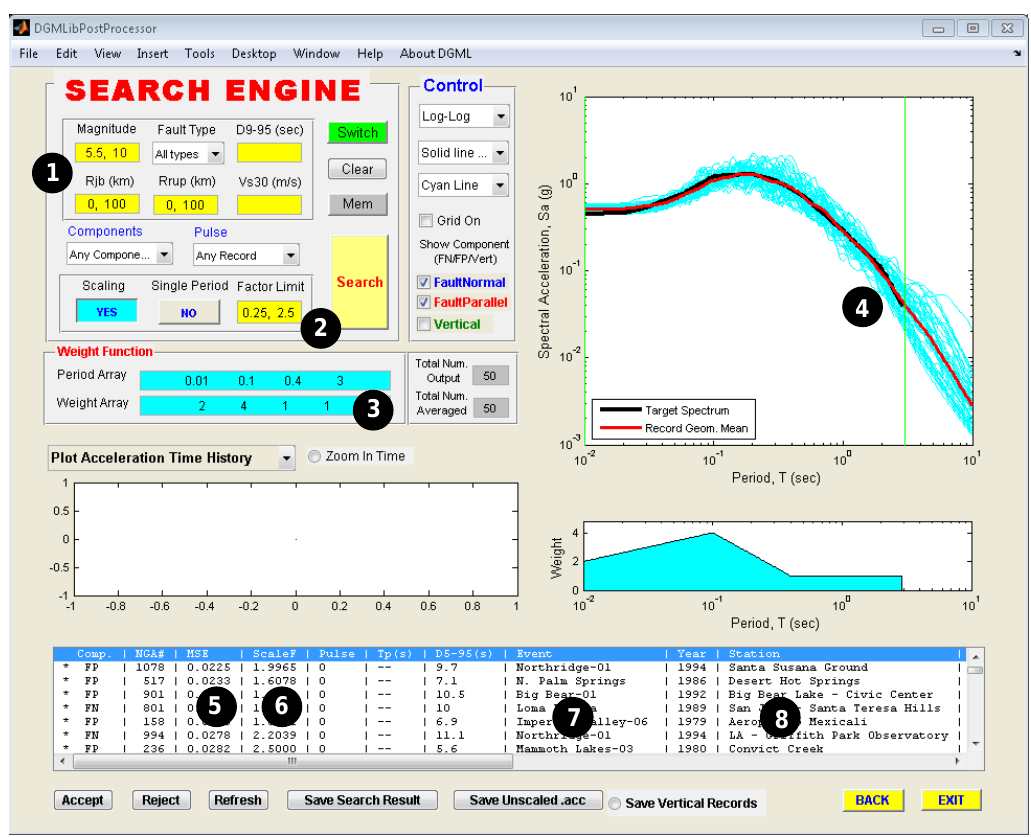
Figure 6. The screenshot of the DGML searching interface: (1) searching criteria, (2) prescribed range of scale factor, (3) prescribed weight factor for spectral period, (4) spectrum plot of selected motions, (5) mean squared error of each individual selected ground-motion record, (6) scale factor of each record, (7) event name of each record, and (8) station name of each